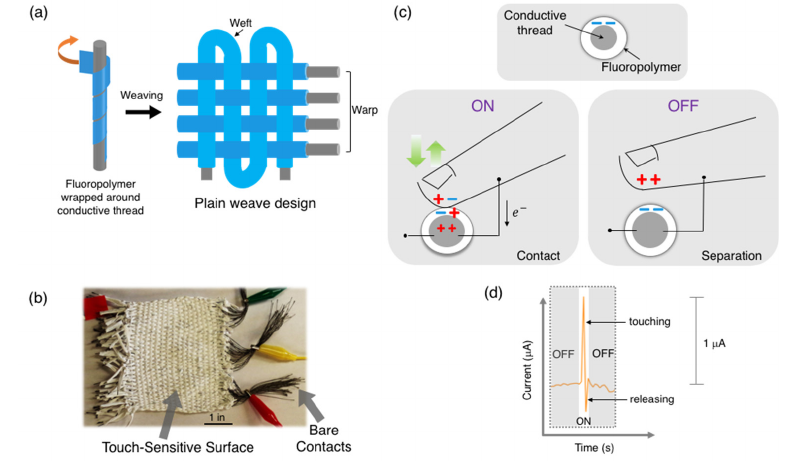
Figure 1. ( a ) Illustrated assembly of a woven textile touch sensor. The fluoropolymer is colored differently in the illustration for clarity. ( b ) Optical image of completed device. ( c ) Surface potential changes caused by skin contact and release. Not depicted to scale. ( d ) Current output of the textile touch sensor for a single touch and release action. The time duration of the “ON” signal is directly related to the duration of skin contact on the textile.